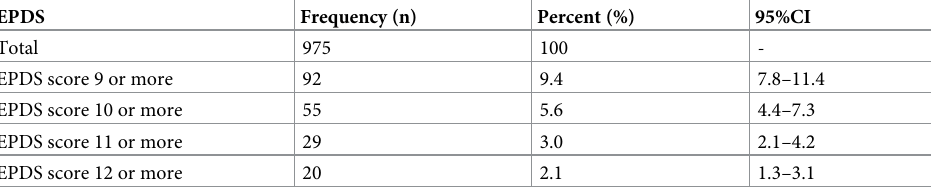
Table 1. Frequency distribution of the EPDS scores with sensitivity analysis among mothers in Galle,